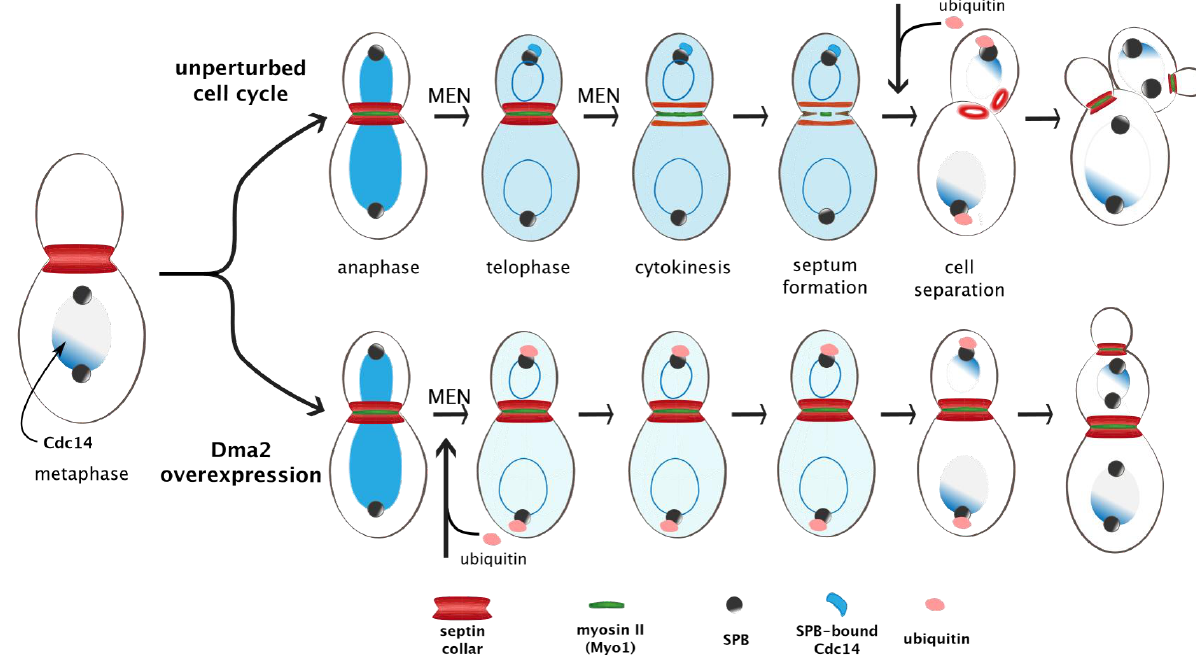
FIGURE 2: Ubiquitylation-mediated control of septin ring splitting and cytokinesis. At the onset of anaphase, the Cdc14 phosphatase (in blue) is released from the nucleolus and diffuses to the nucleus. In telophase, its full release to the cytoplasm prompted by the Mitotic Exit Network (MEN) enables it to reach the spindle pole body (SPB; predominantly the bud-directed SPB) and later on also the bud neck (not depicted). At this stage MEN promotes also septins ring splitting, which in turn allows constriction of the Contractile Actomyosin Ring (CAR) and septum formation. Notice that the myosin II (Myo1) component of the CAR appears at the bud neck in late G1 along with sep- tins, while actin (not depicted) is recruited only in late mitosis in a MEN-independent manner. Once cytokinesis is accomplished, the ubiquitin ligases Dma1/2 ubiquitinate the MEN scaffold Nud1 and shutdown MEN signalling at the SPB. Cdc14 is trapped back in the nu- cleolus and the two daughter cells start a new cell cycle. Upon Dma2 overexpression (bottom), precocious ubiquitylation of Nud1 hinders Cdc14 recruitment to the SPB, thereby preventing septin ring splitting and CAR constriction. Upon cytokinesis failure daughter cells start nevertheless a new cell cycle, forming new septin rings and new buds, resulting in chained cells with a shared